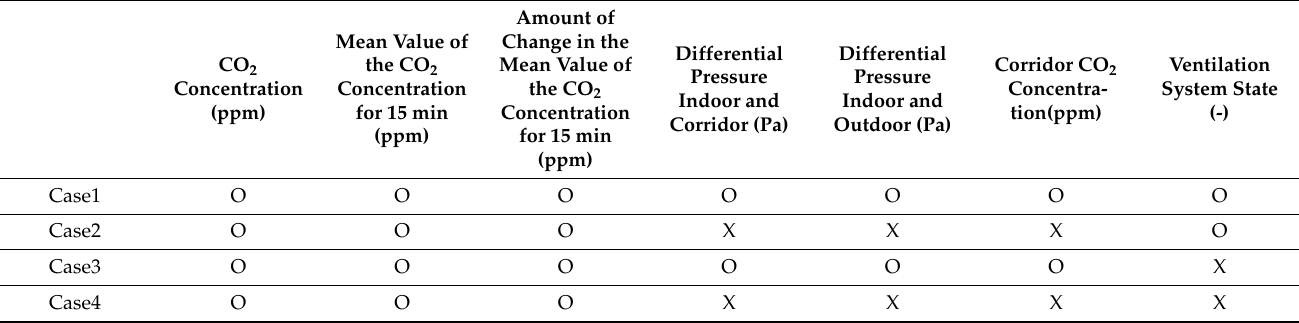
Table 3. The cases of machine